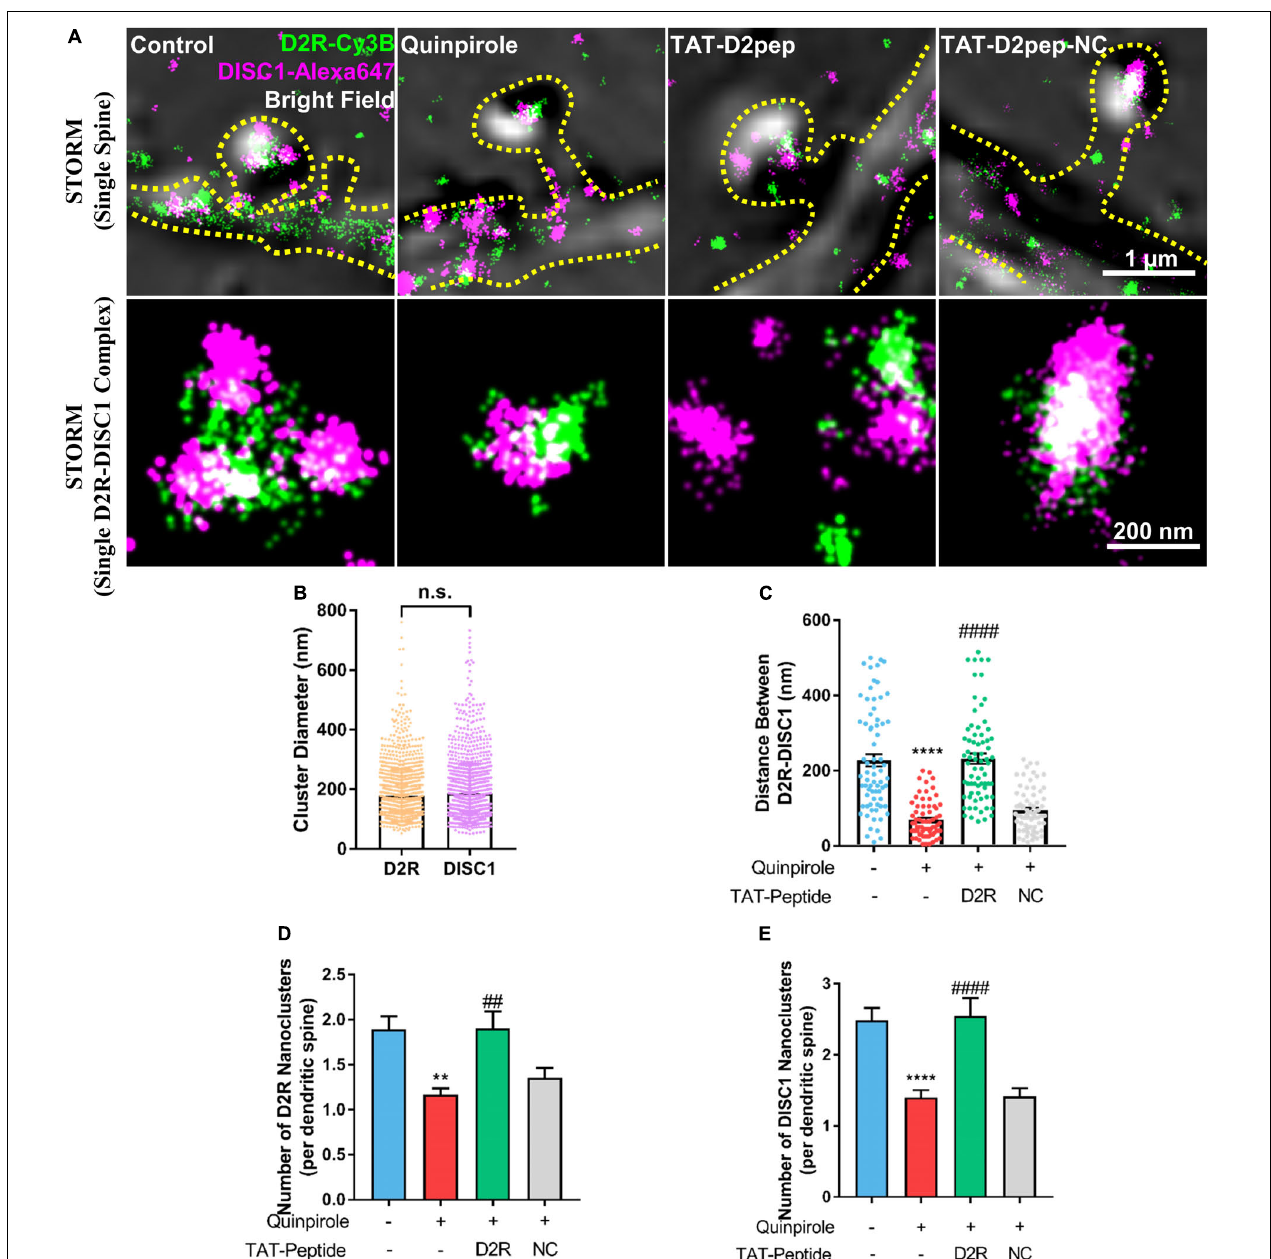
FIGURE 1 | Interaction of D2R–DISC1 in single dendritic spines by STORM analysis. (A) Two-color STORM combined with bright field images show the interaction between D2R (green) and DISC1 (red) in single spines. Upper panels show representative images of D2R–DISC1 complex formation in single dendritic spines. Scale bar = 1 µ m. Lower panels show magnified representative images of single D2R–DISC1 complexes. Scale bar = 200 nm. (B) Diameter of D2R and DISC1 nanoclusters. (C) Quantification of the distance between D2R and DISC1 nanoclusters in dendritic spines by the nearest neighbor algorithm. (D,E) Number of D2R and DISC1 nanoclusters in single dendritic spines. ** P < 0.01 versus control; **** P < 0.0001 versus control; ## P < 0.01 versus quinpirole; #### P < 0.001 versus quinpirole by one-way analysis of variance (ANOVA) with post hoc Tukey